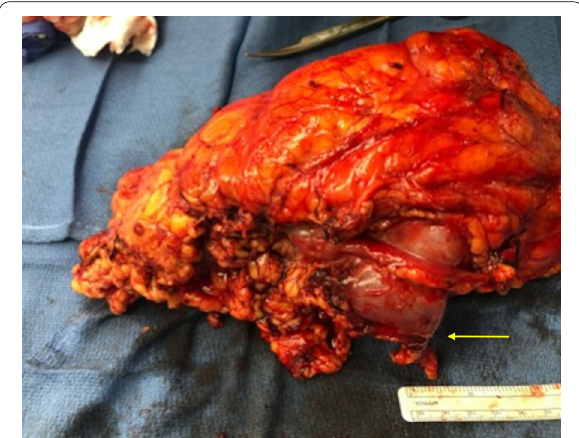
Fig. 4 Excised surgical